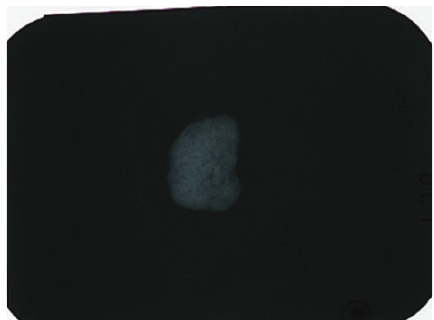
Figure 4: Dental X-rays showed an image of patchy calcification in the